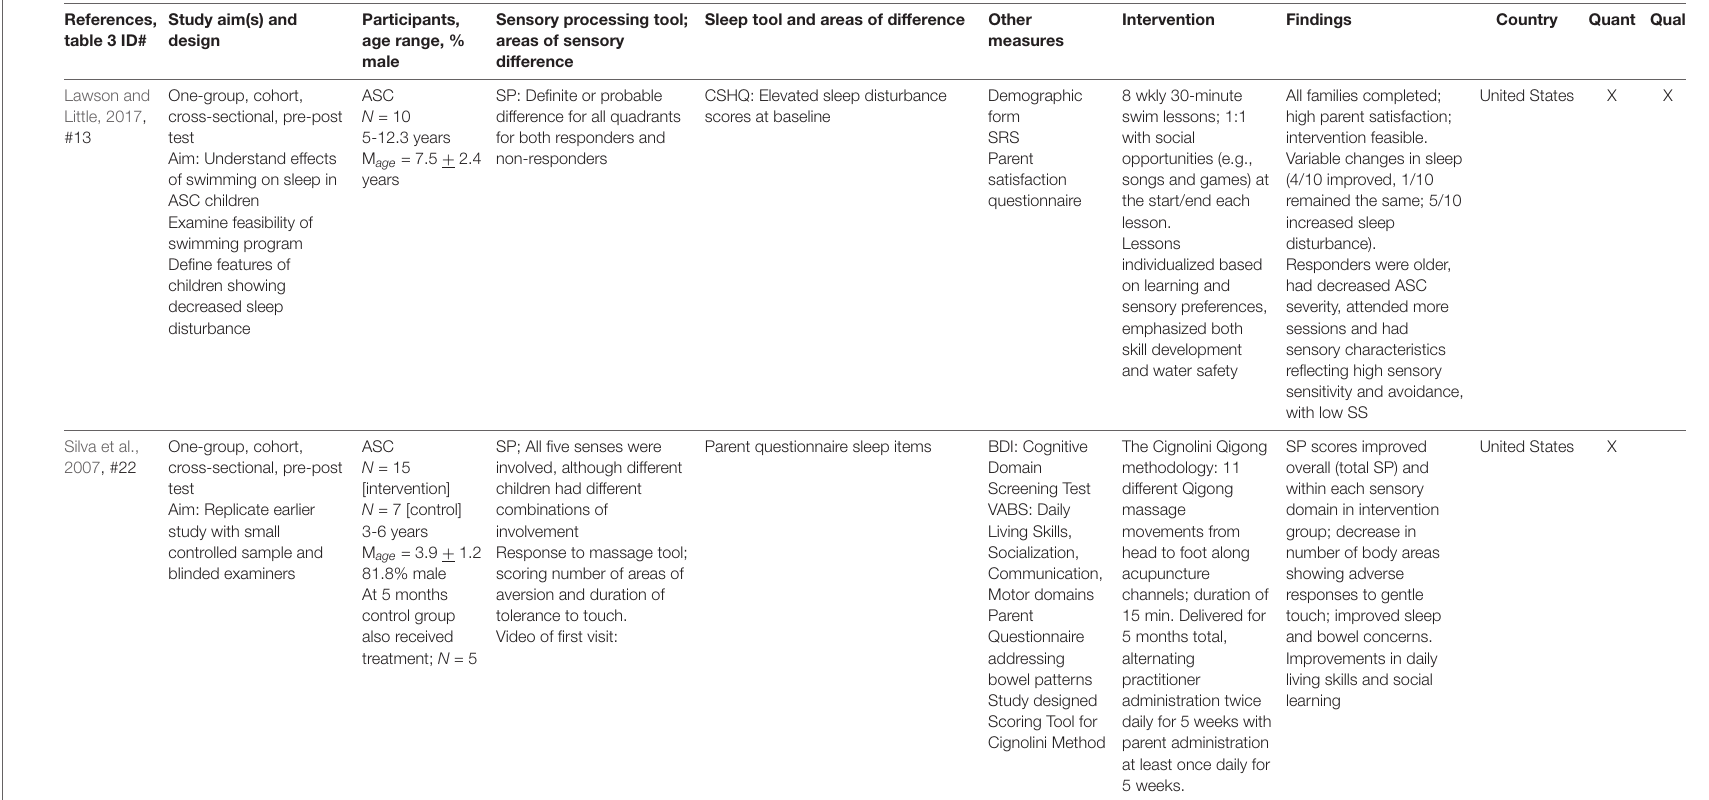
TABLE 3 | Interventions addressing sleep and sensory processing. References, Study aim(s) and table 3 ID#